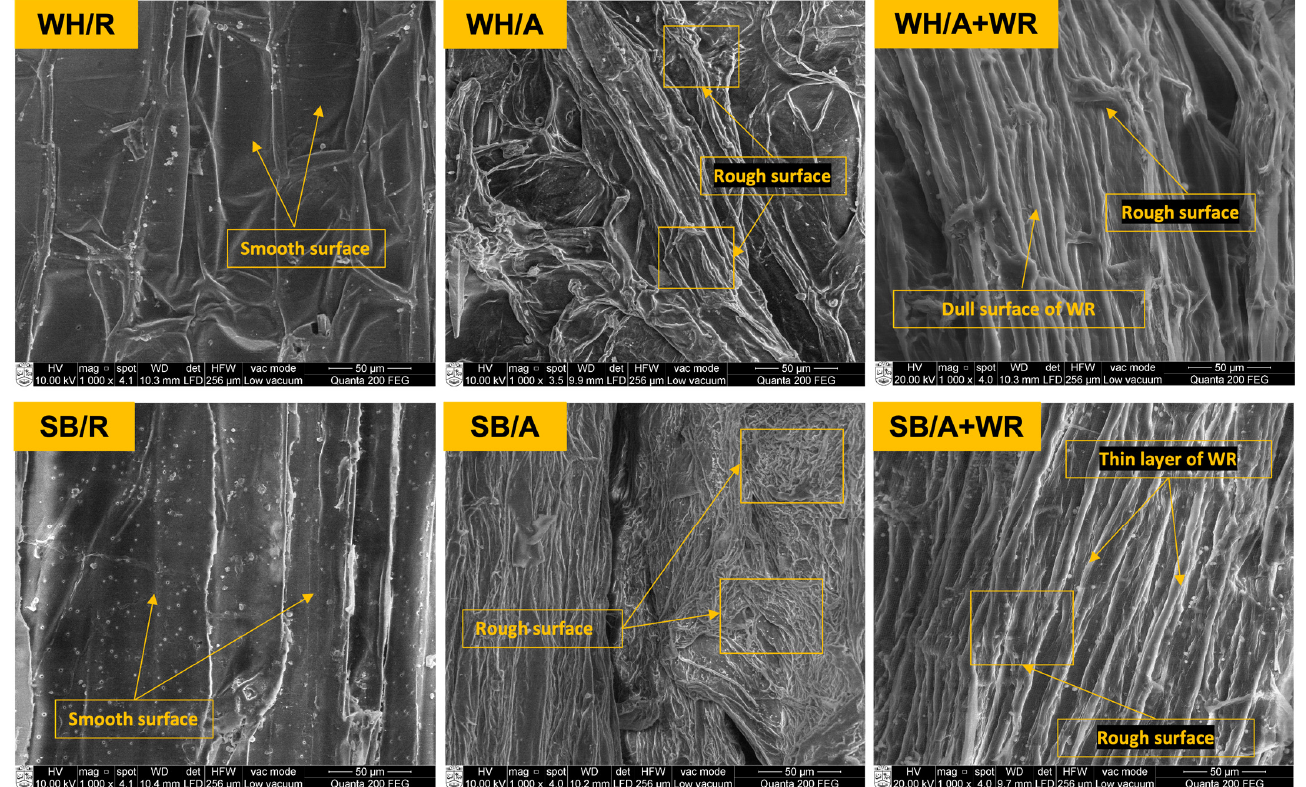
Figure 3. SEM micrographs of untreated (WH/R and SB/R), alkali-treated (WH/A and SB/A) and water-repellent-treated (WH/A + WR and SB/A + WR) water hyacinth and sugarcane bagasse fiber surface.